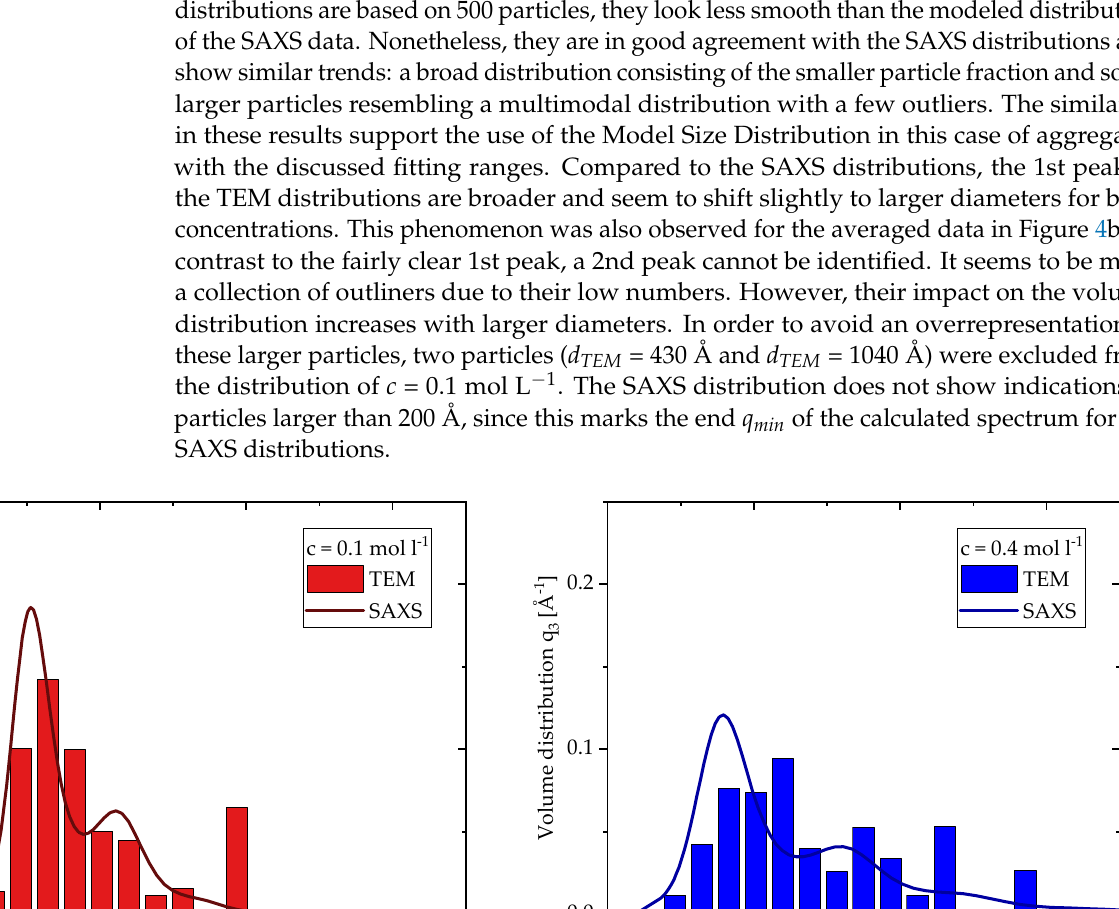
Figure 7. Volume size distribution calculated from TEM and SAXS data of primary particles made by SFS ( a ) with a precursor concentration of c = 0.1 mol L − 1 and ( b ) with a precursor concentration of c = 0.4 mol L − 1